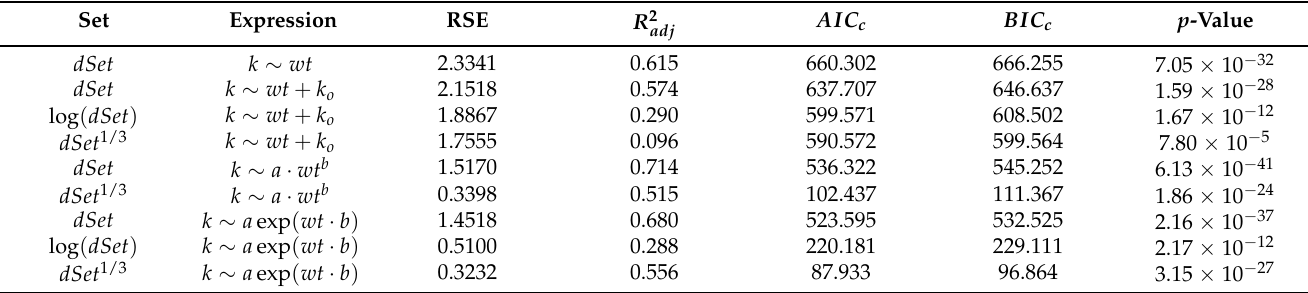
Table 15. Regression results for k vs. wt for the AS